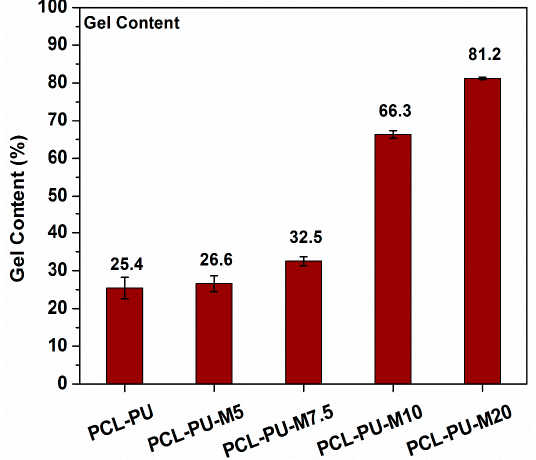
Figure 8. Gel content in the PCL-PU and PCL-PU-Chitosan biocomposites in chloroform.